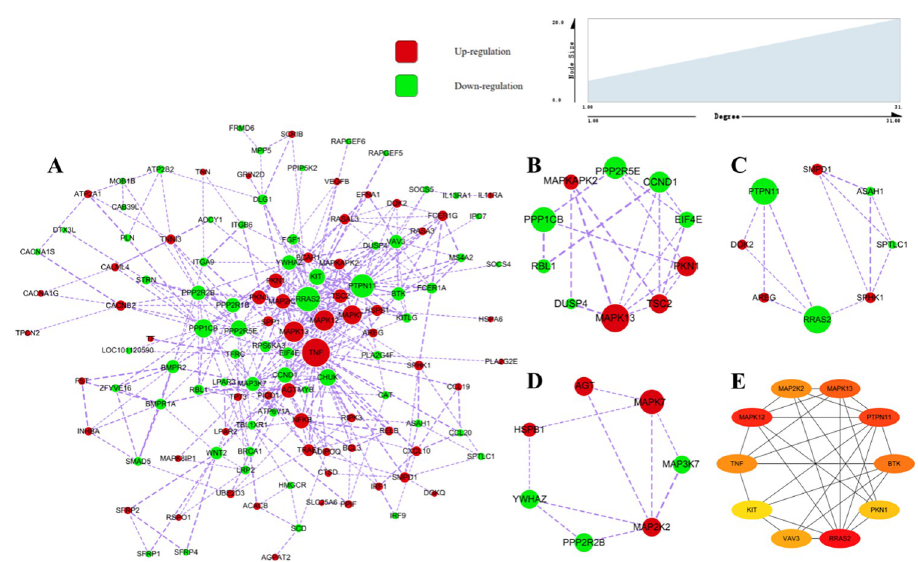
Fig 6. PPI network and hub clustering modules. (A) PPI network analysis for DEGs that were enriched in environmental information processing. (B) Cluster 1 (MCODE score = 4.0). (C) Cluster 2 (MCODE score = 3.4). (D) Cluster 3 (MCODE score = 3.3). (E) The interaction network of the top 10 genes. Red color represents the genes that were up-regulated and green color represents the down-regulated genes. The width of the edges has been related to the combined score between the two nodes. A wider edge indicates a larger combined score.